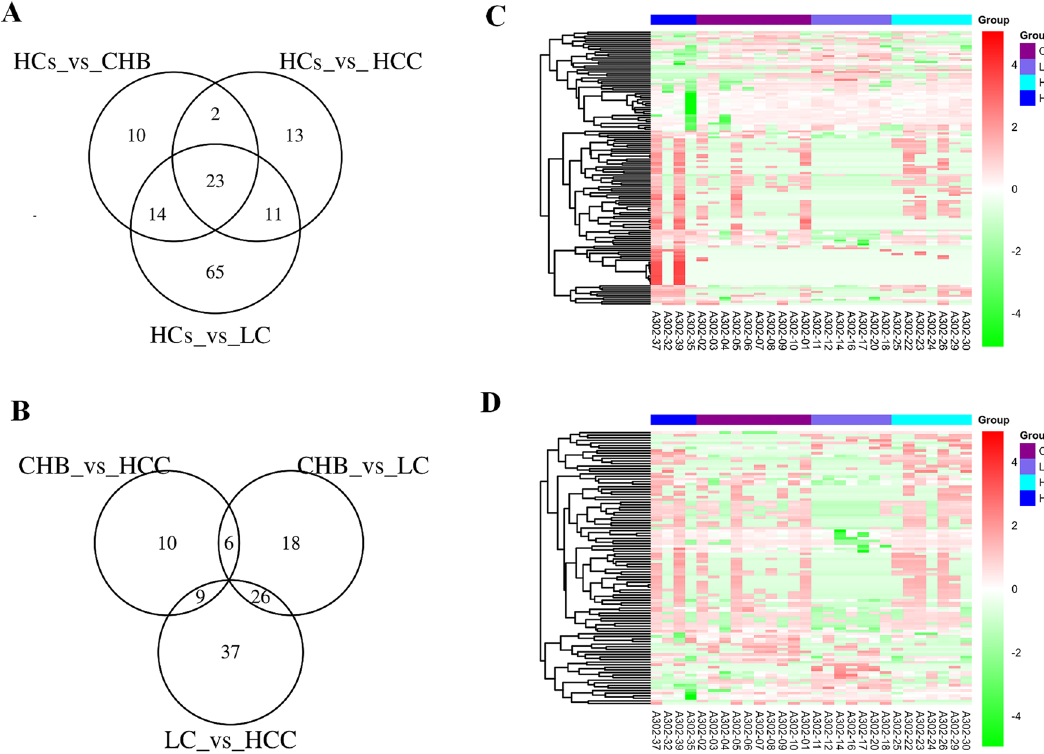
Figure 3. Protein profiles derived from exosome-enriched fractions of chronic hepatitis B (CHB), liver cirrhosis (LC), hepatocellular carcinoma (HCC), and healthy controls (HCs). ( A ) A Venn diagram showing pairwise comparison of differentially expressed proteins between patients with CHB, LC, and HCC against HCs. The Venn diagram was drawn by the R package VennDiagram. ( B ) A Venn diagram showing pairwise comparison of differentially expressed proteins among disease groups (CHB, LC, and HCC). The Venn diagram was drawn by the R package VennDiagram. ( C ) A clustergram of differentially expressed proteins analyzed through pairwise comparison between disease groups (CHB, LC, and HCC) and the HCs group. The clustergram was drawn by the R package Pheatmap. The ordinate represents proteins, and the abscissa represents samples. Clustering was performed using the values of log 10 (label-free quantification + 1, LFQ + 1) and then clustering. On the left, lines in black show the hierarchical clustering of proteins. Colored bars at the top represent CHB, LC, HCC and HCs; the corresponding samples are shown at the bottom. Red and green represent proteins with high and low expression, respectively. ( D ) A clustergram of differentially expressed proteins for pairwise comparison between disease groups (CHB, LC, and HCC). The clustergram was drawn by the R package Pheatmap. The ordinate represents different proteins, and the abscissa represents different samples. Clustering was performed using the values of log 10 (LFQ + 1). Red and green represent highly and lowly expressed proteins,